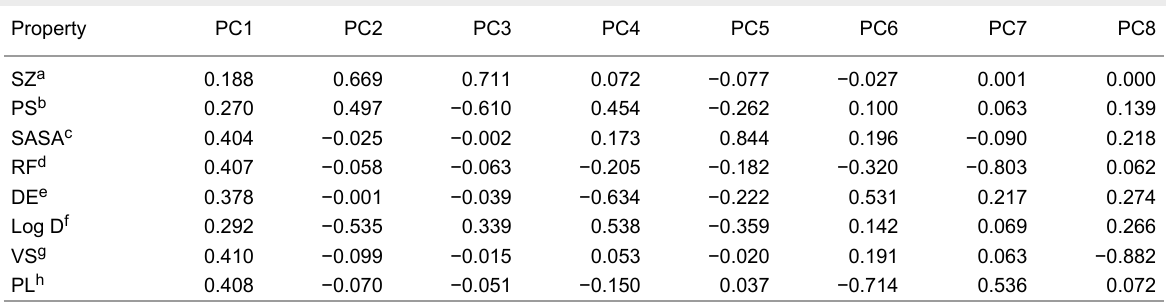
Table 3: Rotation of PCA (weighting of each property). Property